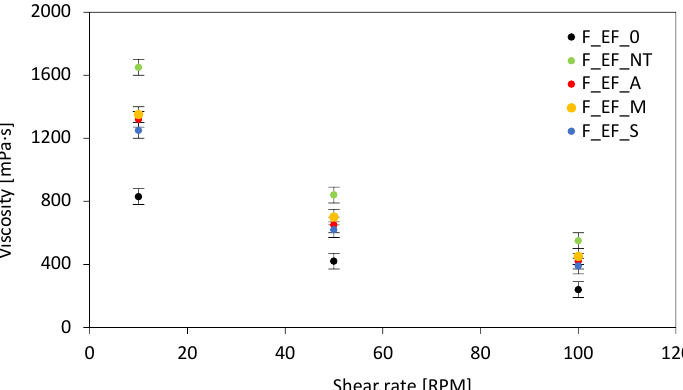
Figure 5. The viscosity of the polyol system modified with eucalyptus fibers in the function of the shear rate.